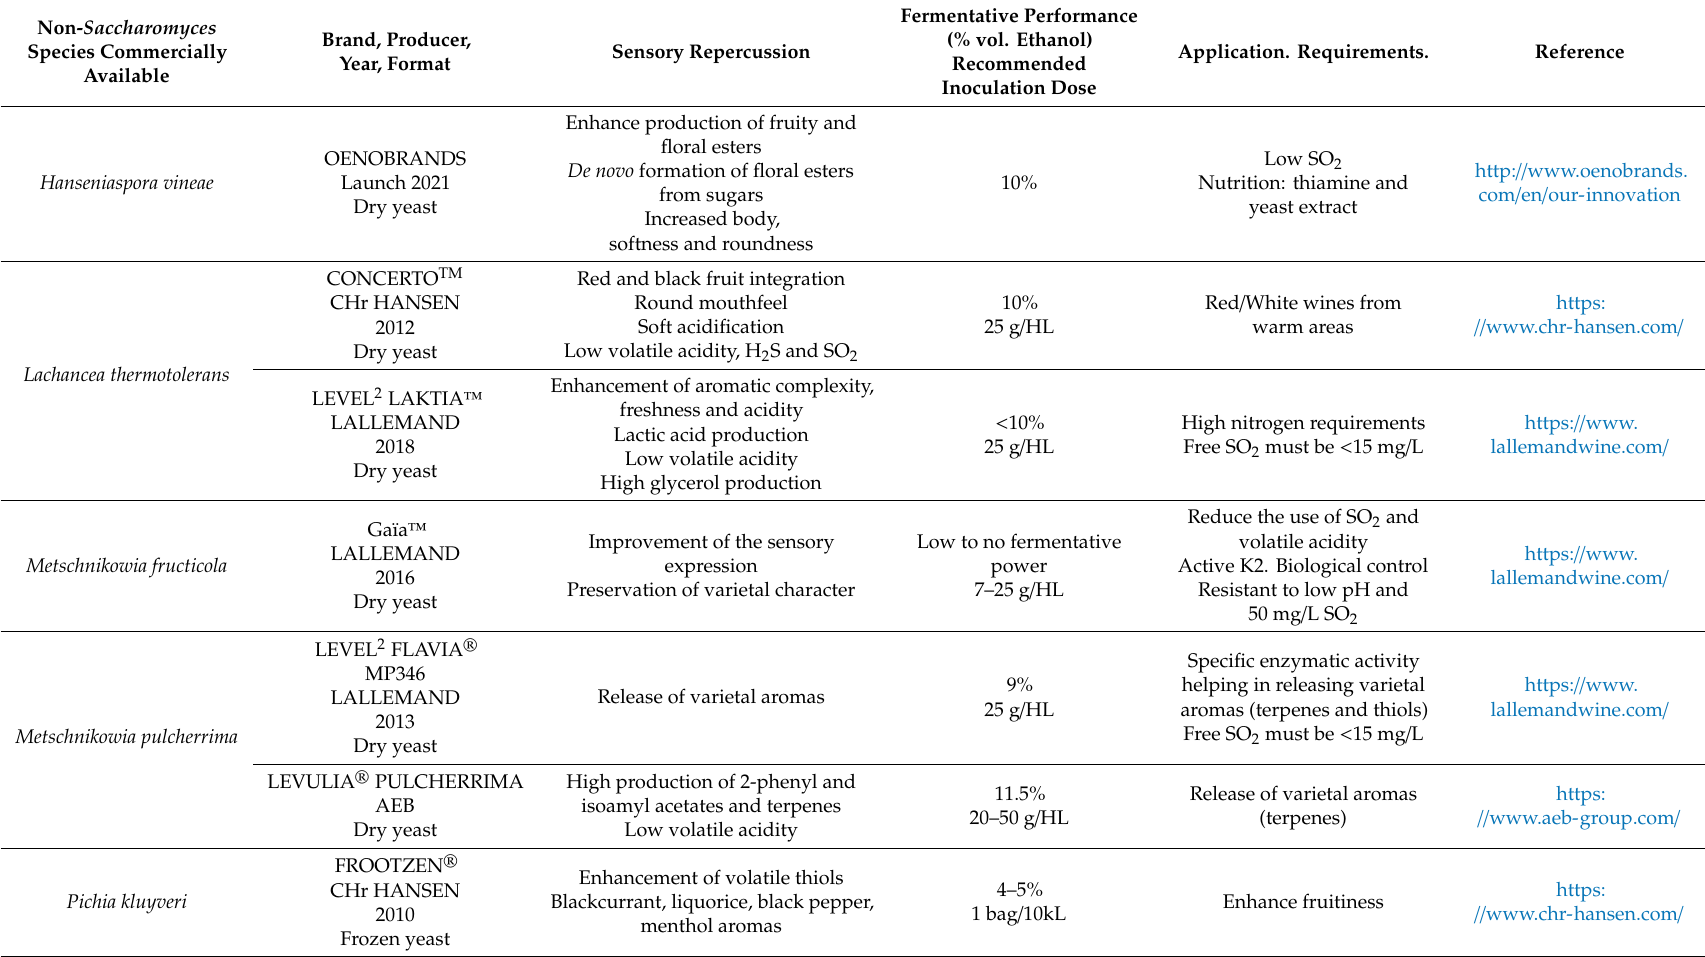
Table 2. Non- Saccharomyces species commercially available and main applications in wine